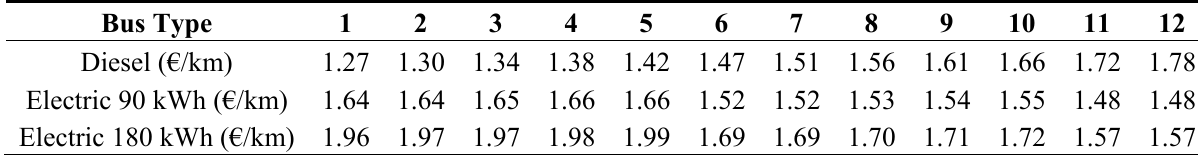
Table 2. Price per kilometer development for diesel and electric buses taking all above explained costs into account and showing the impact of battery costs on the overall costs per